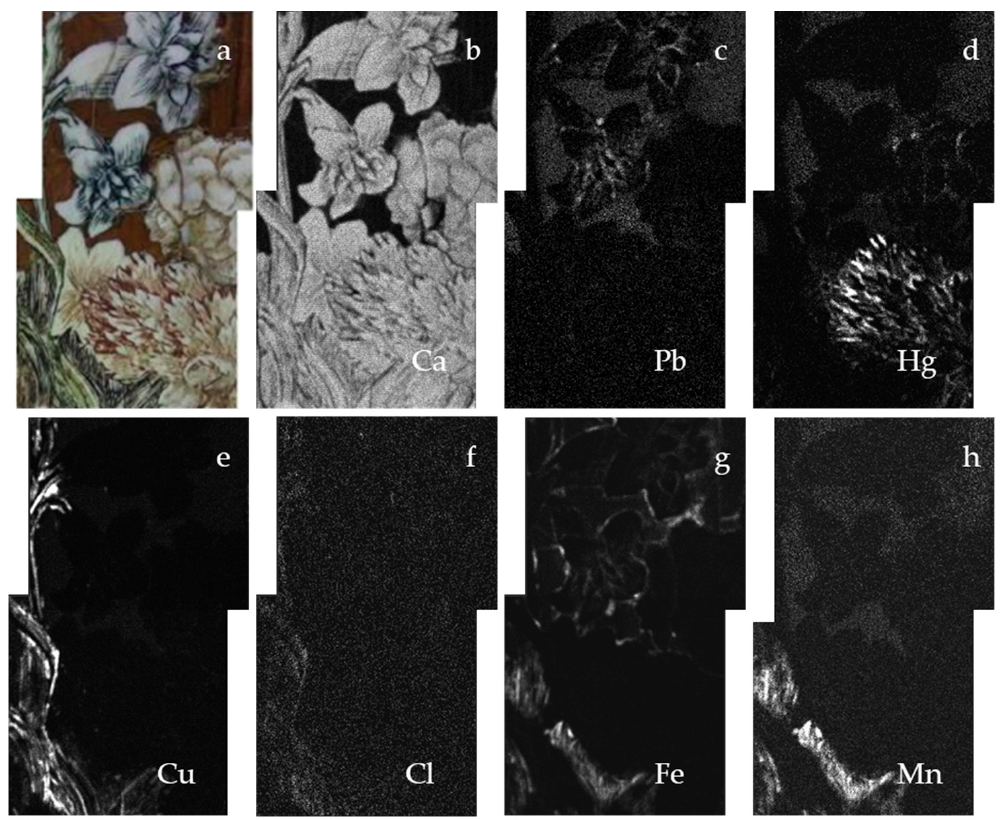
Figure 8. Elemental maps of the external area of the Scrivania con scansia obtained by the INFN-CHNet MA-XRF scanner. ( a ) Visible. The maps presented are: ( b ) Ca K α transition; ( c ) Pb L α transition; ( d ) Hg L α transition; ( e ) Cu K α transition; ( f ) Cl K α transition; ( g ) Fe K α transition; ( h ) Mn K α transition.